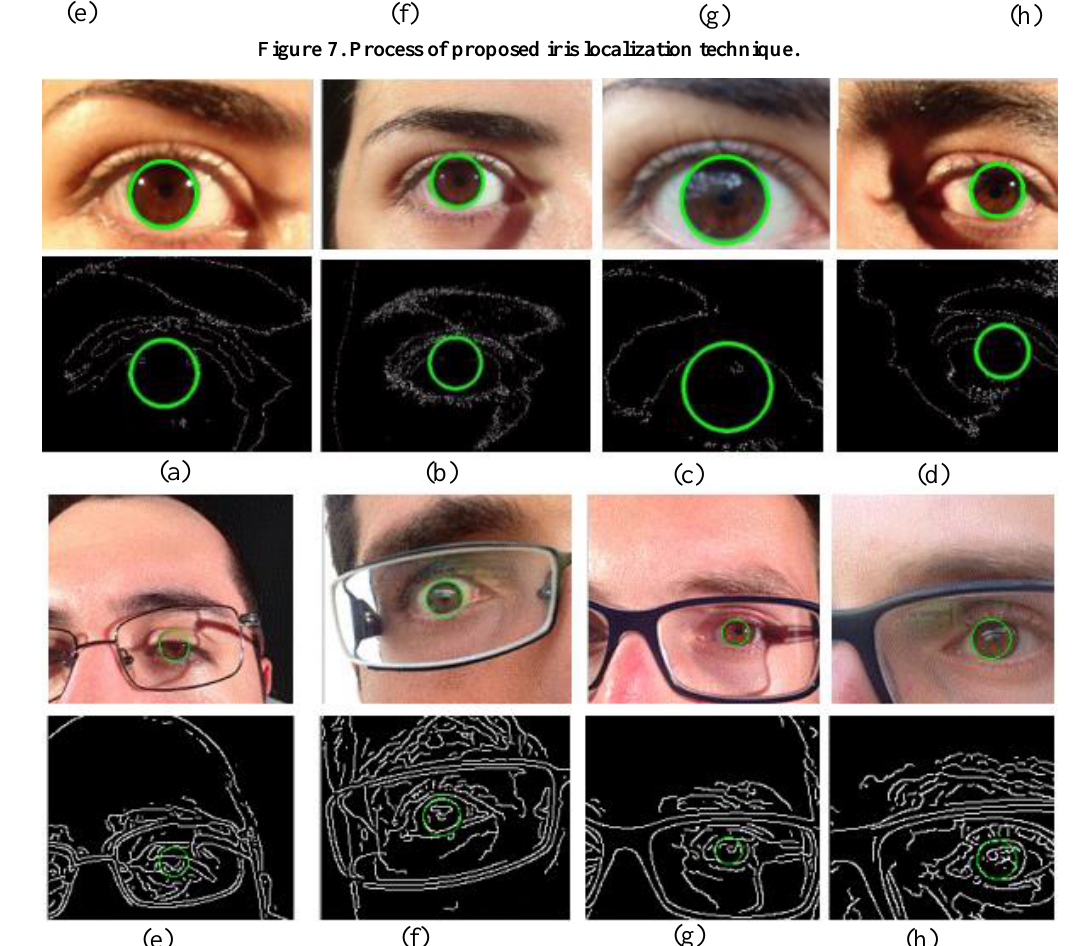
Figure 7. Process of proposed iris localization technique.